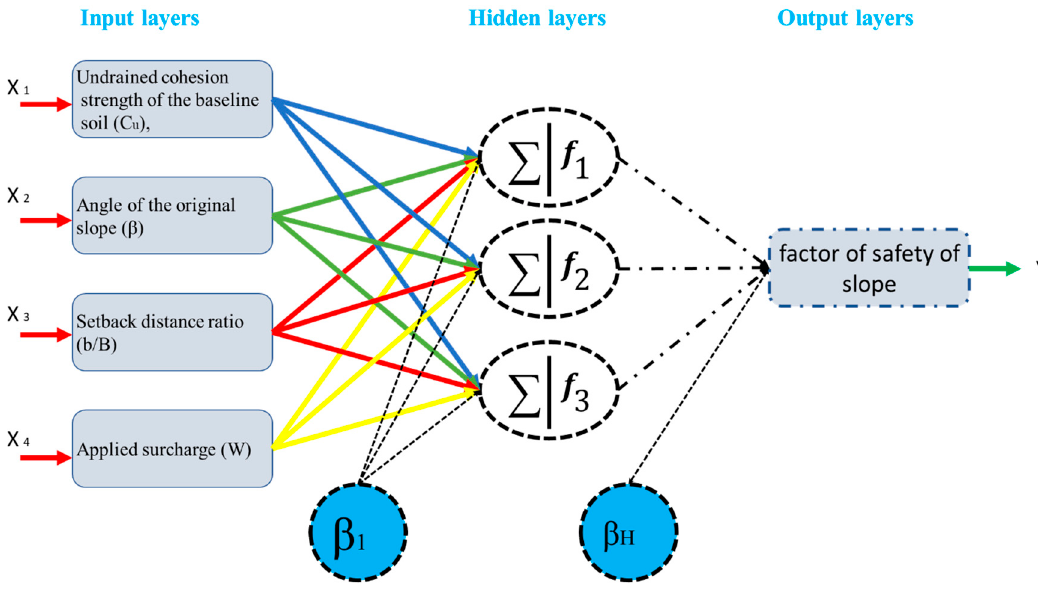
Figure 1. Typical architecture of multi-layer perceptron (MLP) neural network.